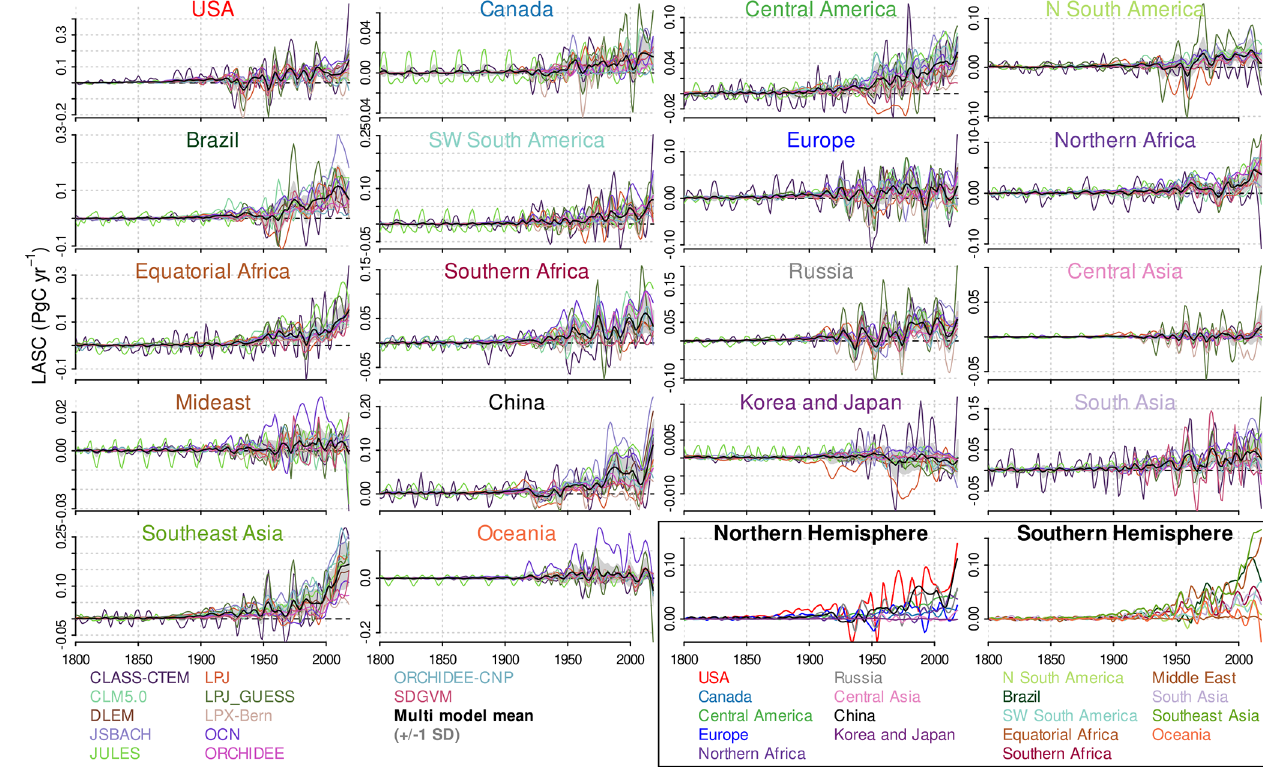
Figure A4. Region-wise smoothed annual loss of additional sink capacity (LASC) in the investigated DGVMs from 1800 to 2018, derived according to Eq. (4). For discussion of individual models refer to Sect. A1. The last two panels show regional ensemble means on a uniform